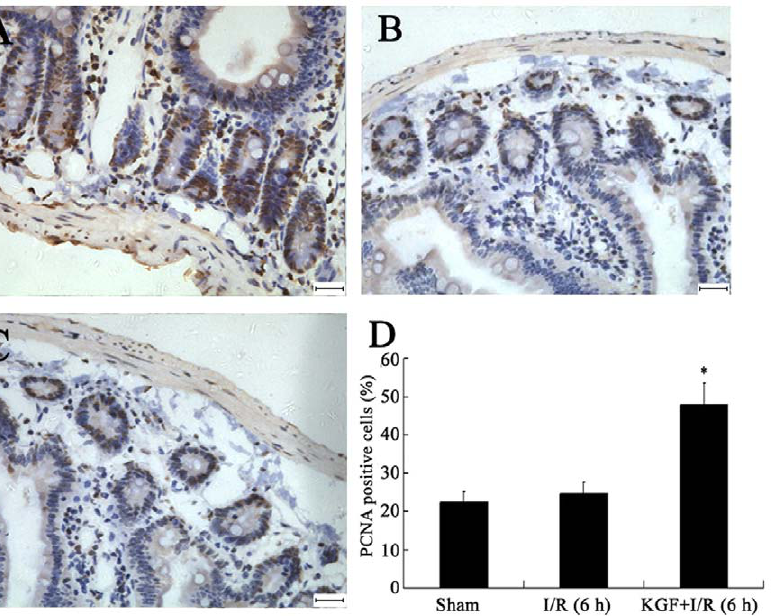
Figure 4. Alterations in PCNA expression in small intestine of KGF treated mice by immunohistochemistry. PCNA expression was significantly increased in I/R + KGF (6 h) group (A), as compared to the I/R (6 h) group (B) and sham group (C). Original magnification: 6 400; (D) PCNA